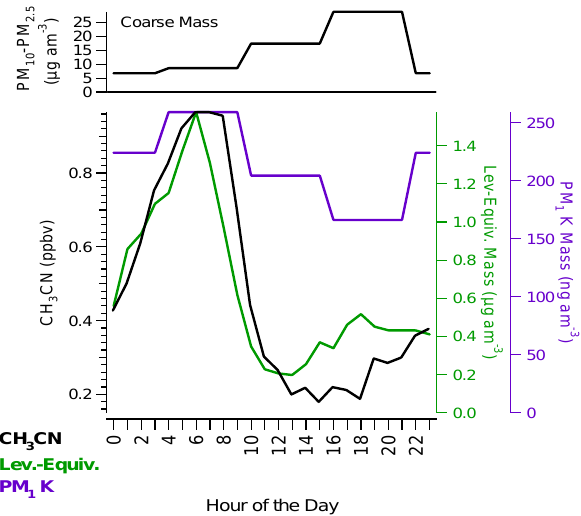
-PM ) from the measurements of Querol et al. (2008). Bottom: Diurnal cycles of gas-phase 10 2.5 total potassium. 1